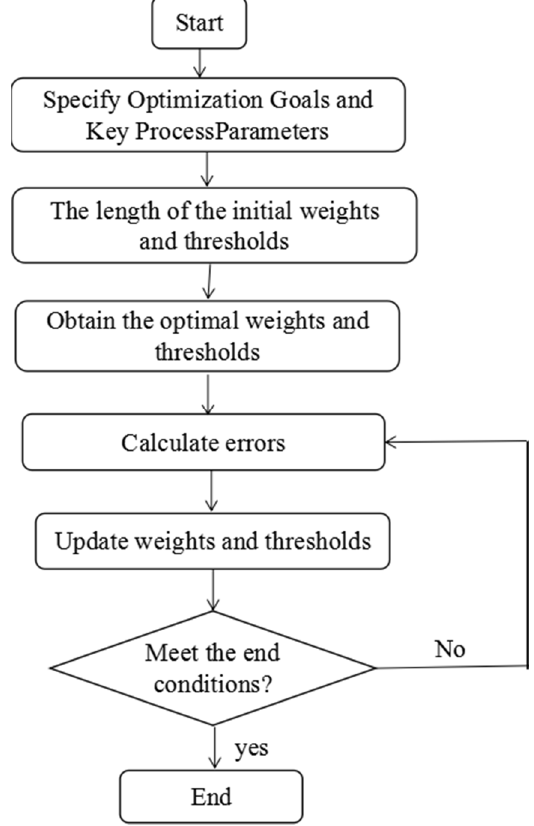
Figure 2. Flow diagram of ANN training.